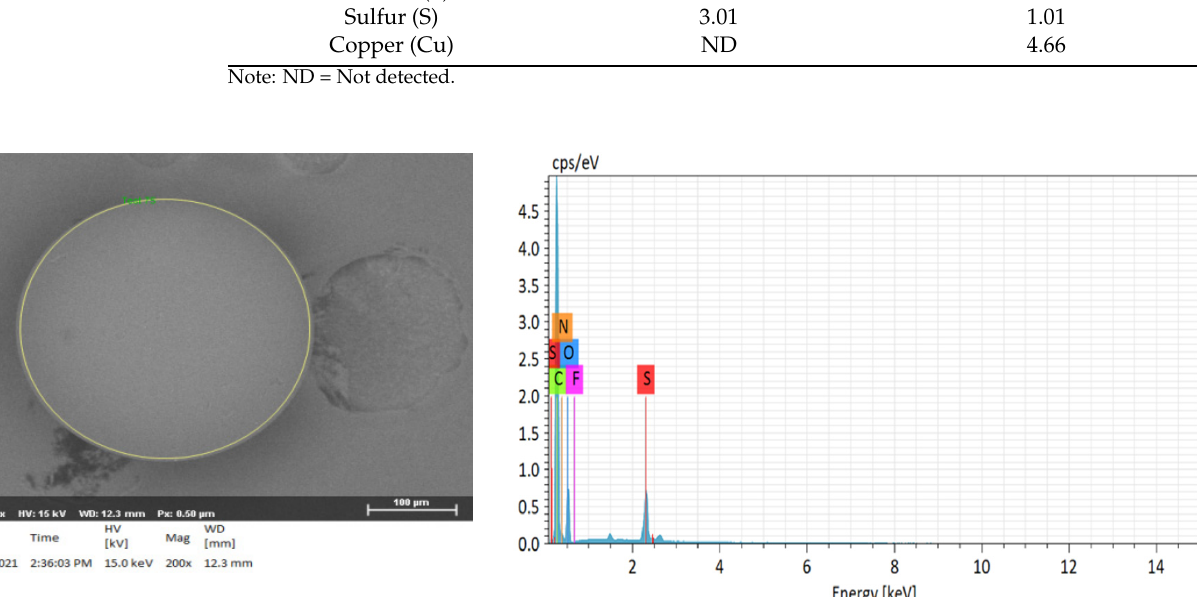
Figure 6. Possible mechanism of ion exchange of H + Dowex-M4195 chelating resin with Cu(II).